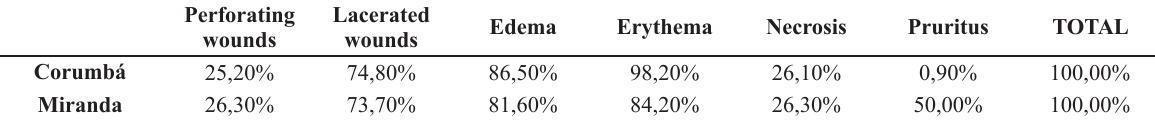
Profile of the lesions caused by the Pseudoplatystoma genus in professional fishermen of Corumbá e Miranda towns